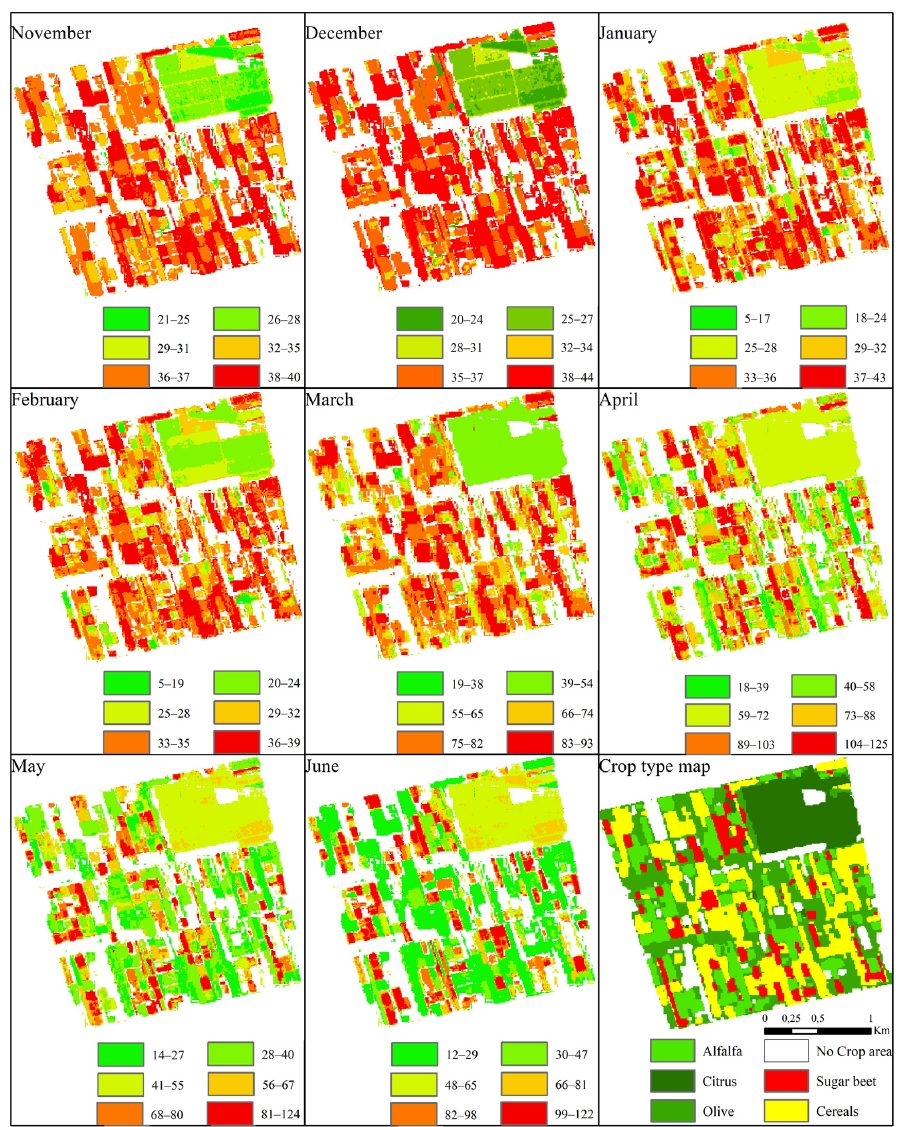
Figure 10. Monthly water requirements during the 2016/2017 agricultural